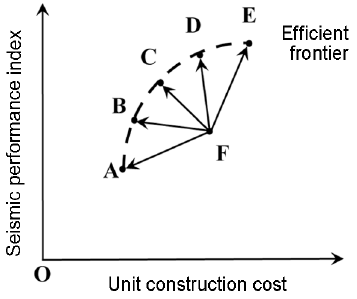
Fig. 4. Benchmarks and planning efficiency improvement